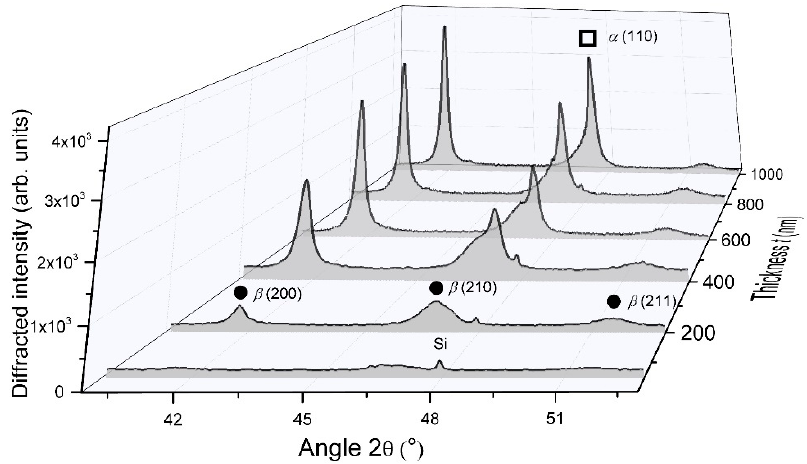
Figure 3. XRD patterns of W thin films sputter-deposited on (100) Si substrate with an angle α = 80°, an argon sputtering pressure of 4.0 × 10 − 3 mbar and for a thickness changing from 50 to 1000 nm. Only the 41°–52° range is presented since no significant peaks were measured elsewhere. Diffracted signals showed the occurrence of α and β phases ( π and λ , respectively).